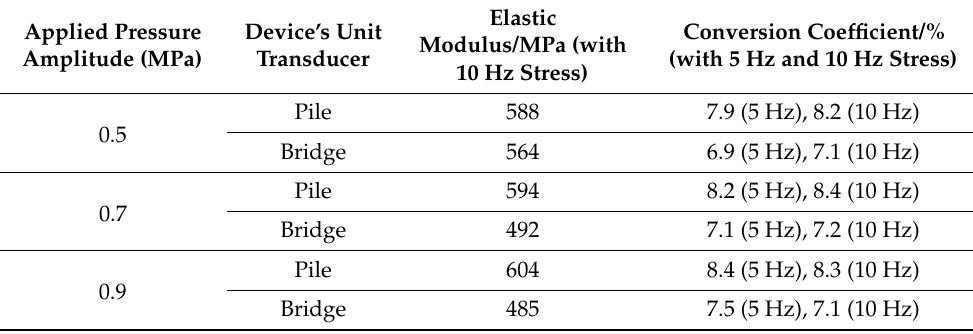
Table 2. Elastic modulus and electromechanical conversion coefficient of the PE devices presented in